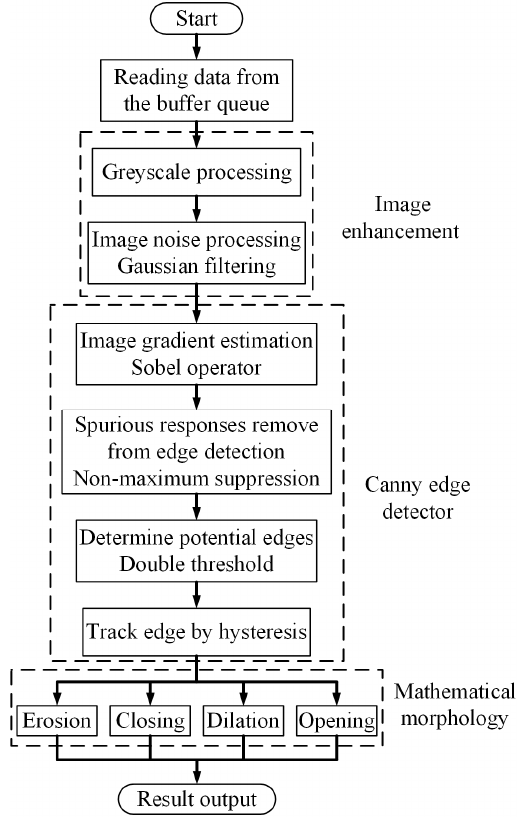
Figure 4. Obstacle contour extraction process.